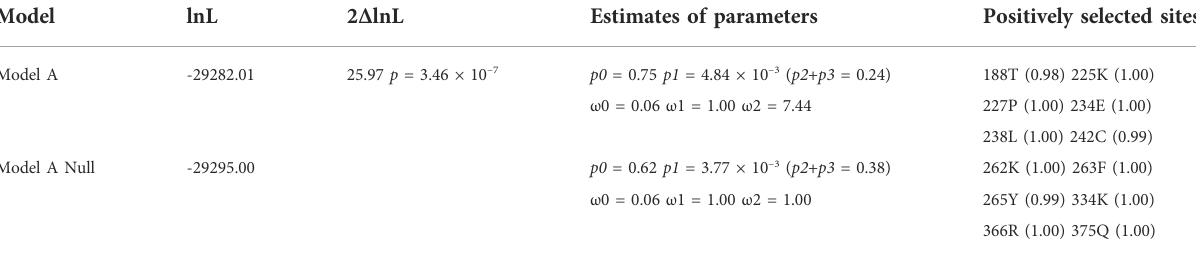
TABLE 2 The branch-site model test result for CpPLD2 and PpPLD11 .